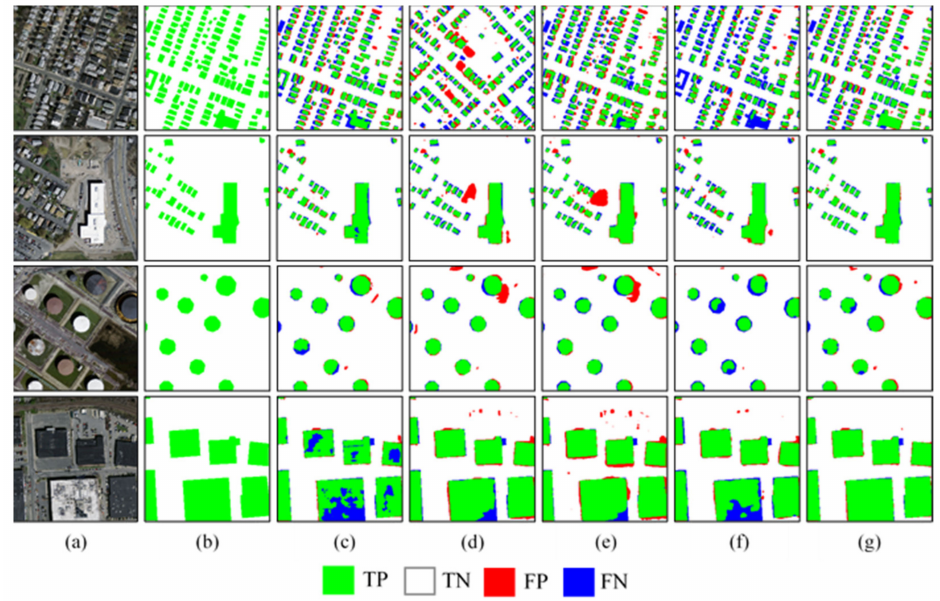
Figure 10. Results of building footprint segmentation on the Massachusetts dataset. ( a )